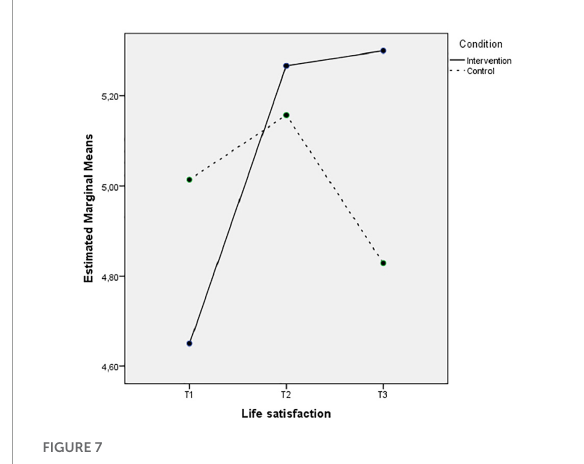
FIGURE7 Mean of life satisfaction showing time effects for control and intervention groups.